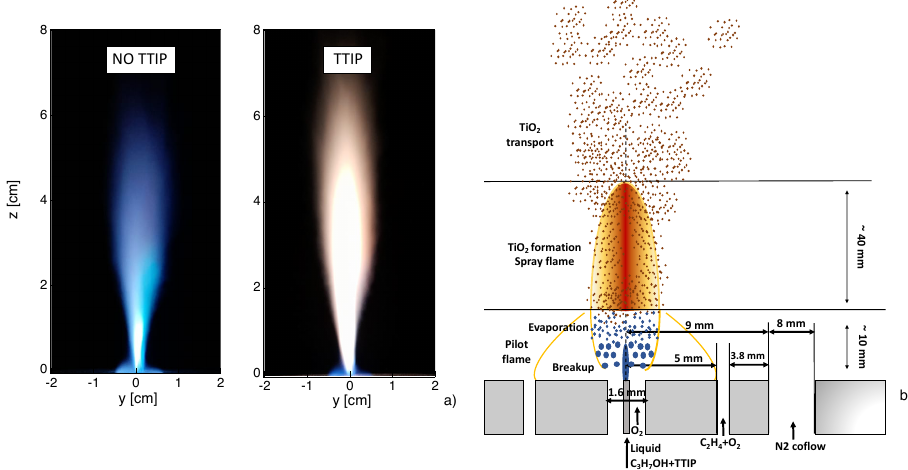
Figure 1. ( a ) Flame luminosity without and with injection of TTIP. ( b ) Schematic presentations of the reactor inlet and of the processes inside the